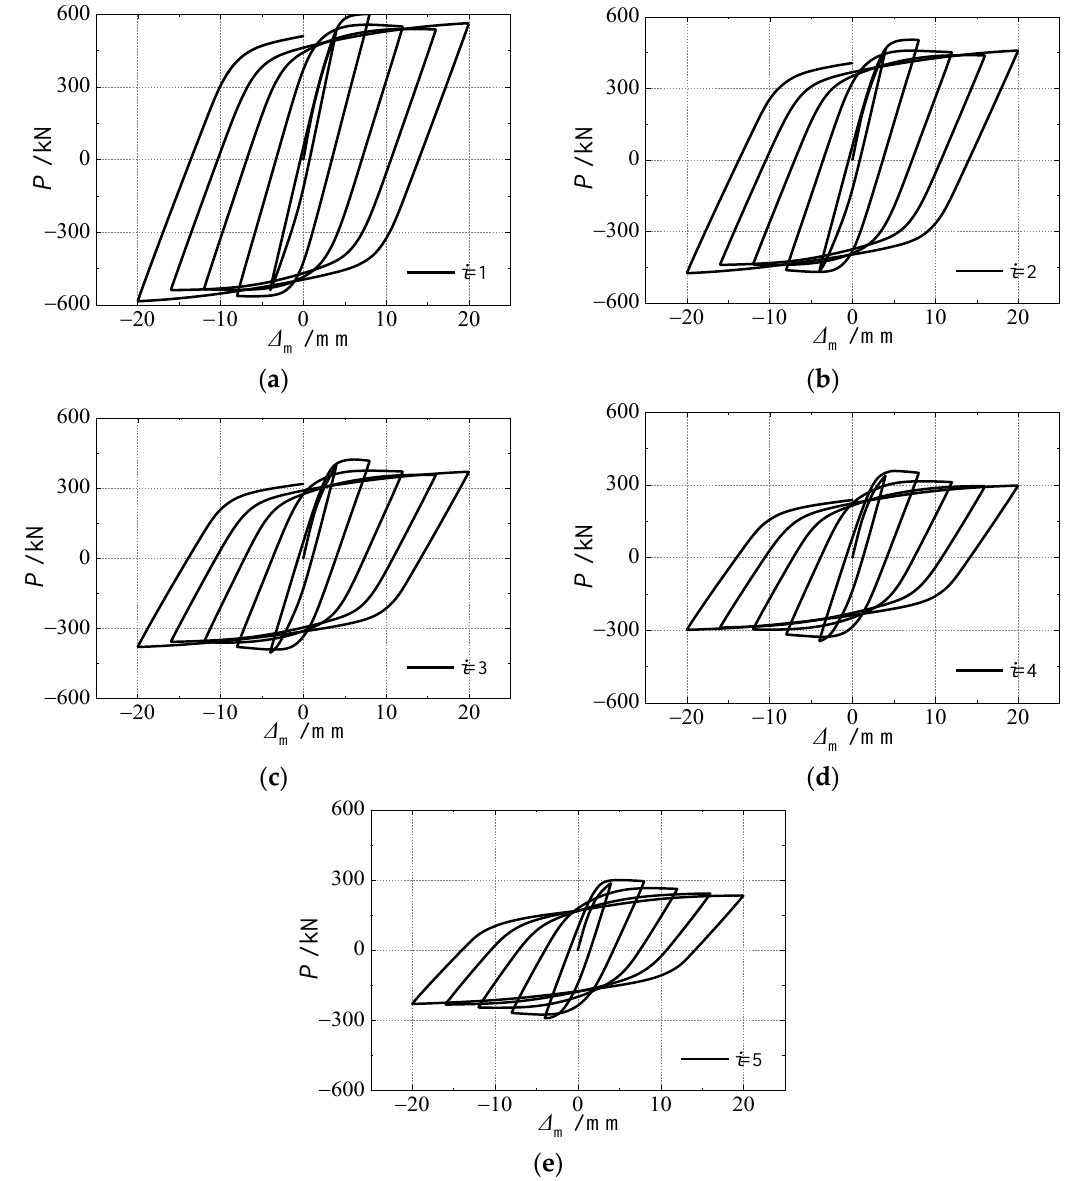
Figure 21. Effect of alternation time on hysteretic curve. ( a ) i = 1; ( b ) i = 2; ( c ) i = 3; ( d ) i = 4; ( e ) i = 5.